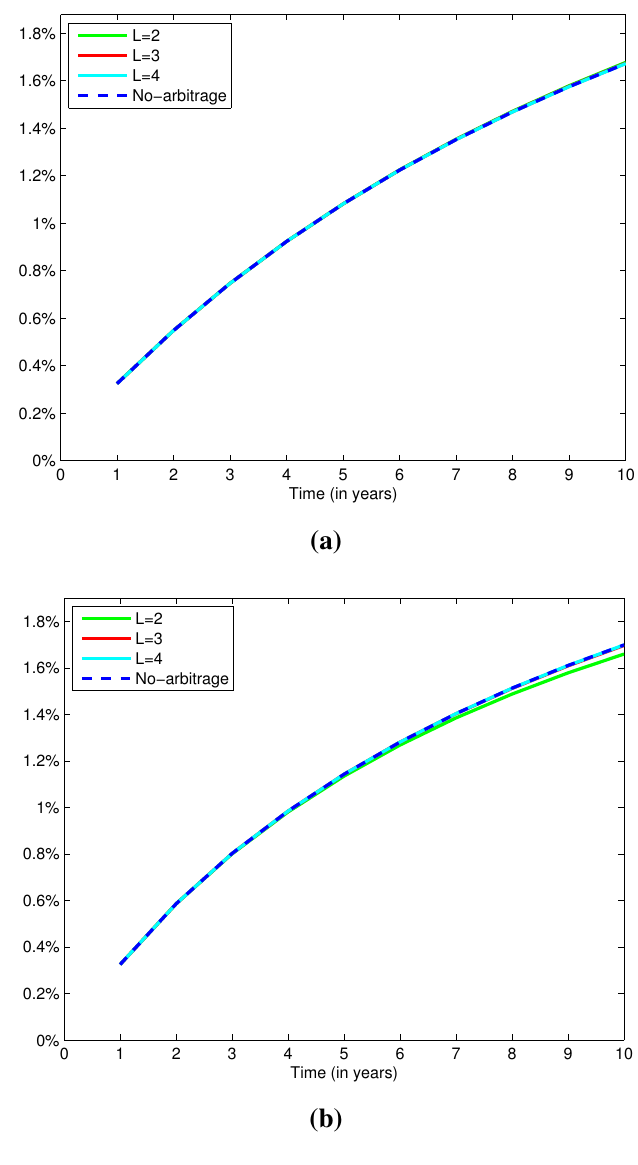
Figure 5. No-arbitrage and best-estimate projected yield curves. ( a ) Parameter set 3; ( b ) Parameter set